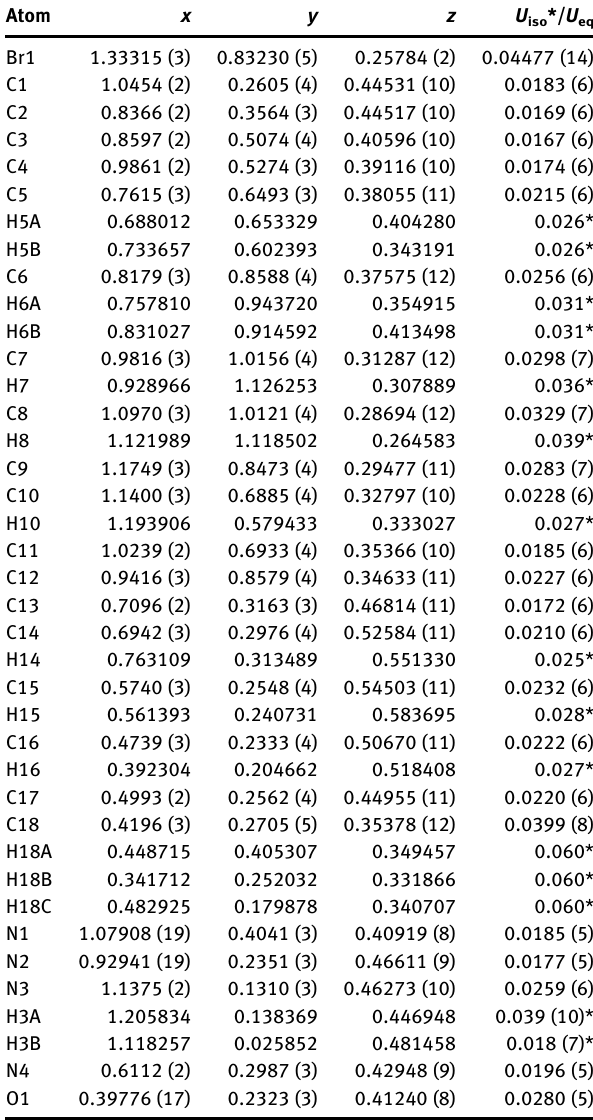
Table  : Fractional atomic coordinates and isotropic or equivalent isotropic displacement parameters (Å 